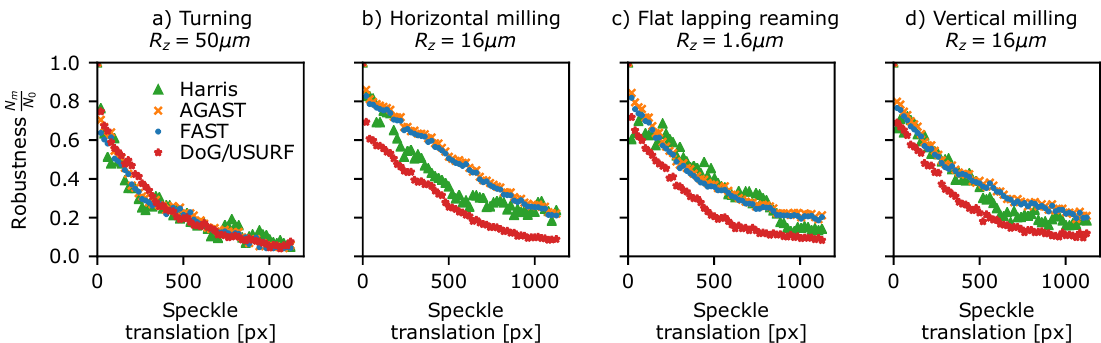
Figure 7. Detector translational robustness plotted against measured speckle translation for a selection of surface treatments shown in Figure 1. ( a ) Turning R z = 50 µ m, ( b ) horizontal milling R z = 16 µ m, ( c ) flat lapping reaming R z = 1.6 µ m, and ( d ) vertical milling R z = 16 µ m.